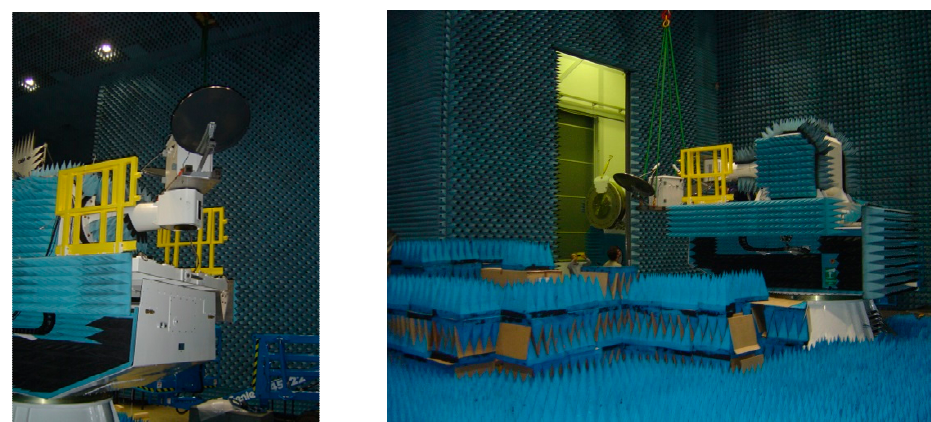
Figure 6. Characterization and calibration procedures for the transponder to access its uncertainty at the European Space Agency (ESA) facilities in the Netherlands (The Compact Payload Test Range Facility).